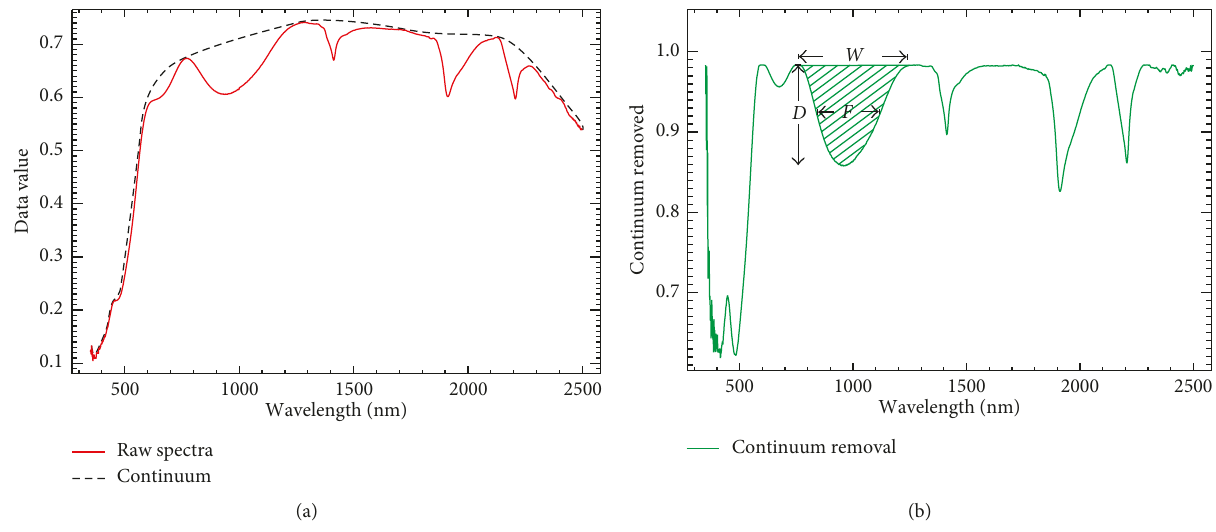
Figure 2: (a) Continuum removal of the spectrum corresponding to a red earth soil sample [24]; (b) a continuum-removed spectrum and some spectral parameters (i.e., W , D , and F